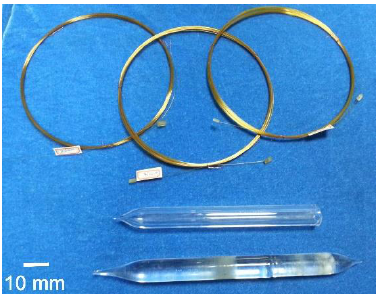
Figure 4. Appearance of PI-coated chromatographic column (CC) samples ( top ) and pristine quartz rods ( bottom ).